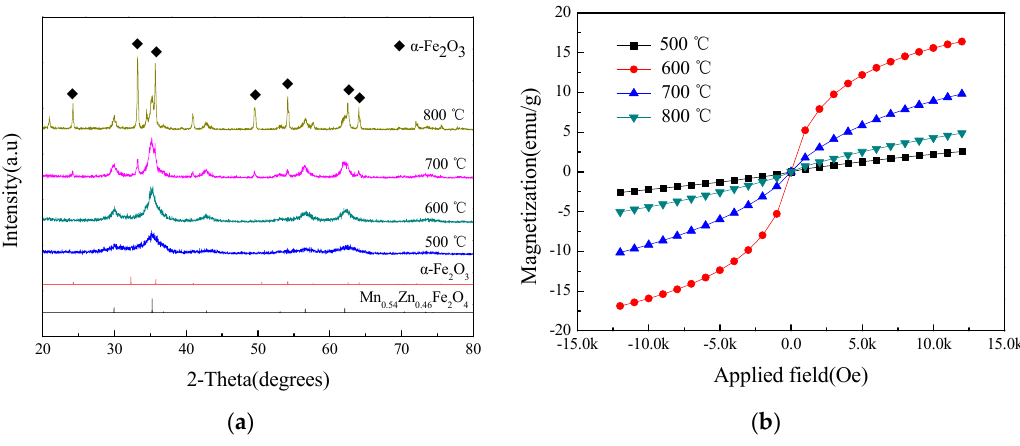
Figure 5. The effect of the sintering temperature in an air atmosphere on ( a ) the crystal phase and ( b ) the magnetic properties.